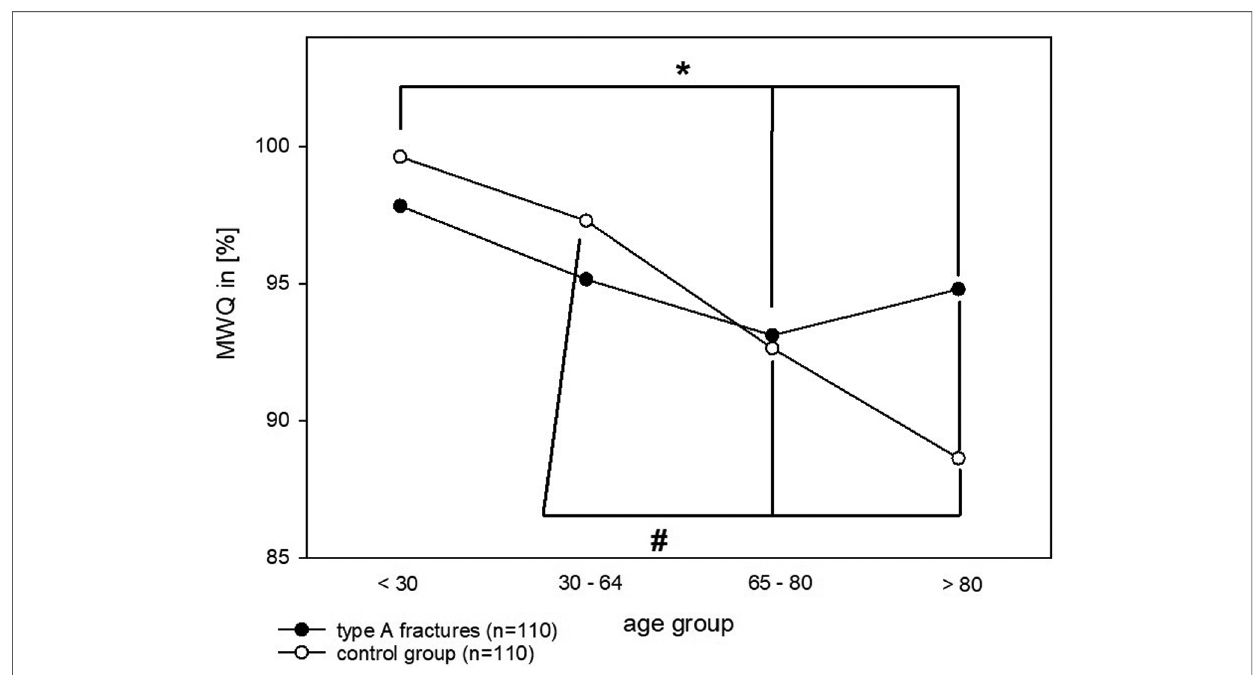
FIGURE 3 This fi gure shows MWQ values for both control and fracture groups separated in their age groups. There was a signi fi cant difference in the control group: ANOVA on ranks: p <0.001; Dunn ’ s pairwise: <30 vs. 65 – 79 (* p =0.001), <30 vs. >80 (* p <0.001), 30 – 64 vs. 65 – 79 (# p <0.001), and 30 – 64 vs. >80 years (# p =0.003). There was no signi fi cant difference in the fracture group ( p